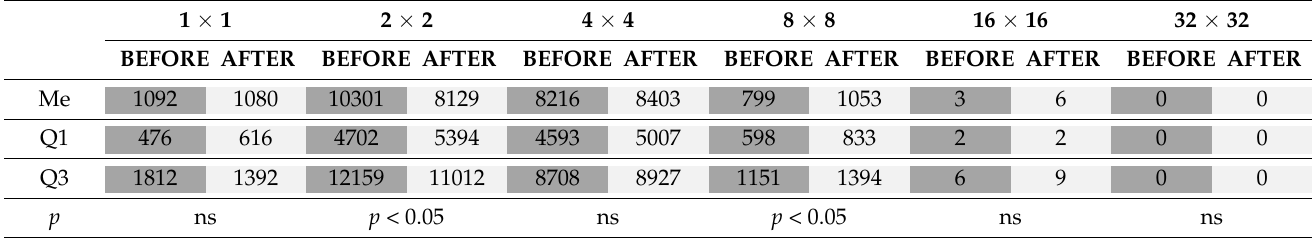
Table 3. The number of blocks with sides of 1 × 1, 2 × 2, 4 × 4, 8 × 8, 16 × 16 and 32 × 32 pixels, resulting from the quadtree decomposition of the right cheek image recorded with a cross-polarization filter before the series of treatments (BEFORE) and after the series of treatments (PO. Me = median; Q1 = lower quartile; Q3 = upper quartile; p = level of statistical significance; ns = no